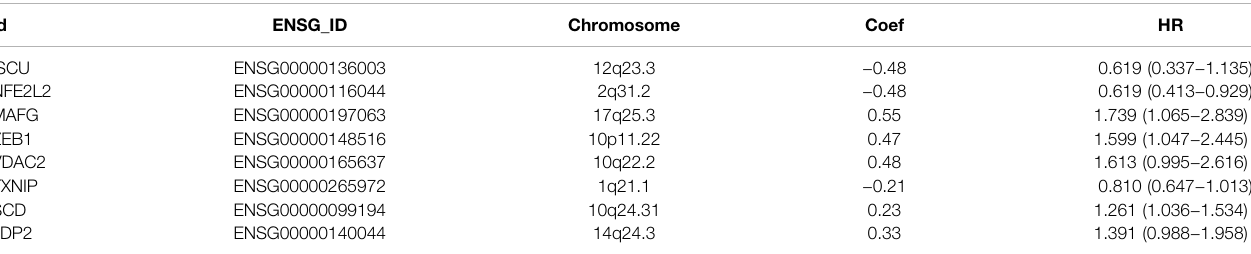
TABLE 4 | Detailed information on ferroptosis-related genes for constructing the prognostic signature.